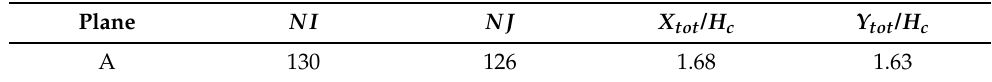
Table 1. Basic geometric and grid parameters: NI and NJ are the numbers of the grid lines with respect to the x and y direction, while X tot and Y tot are the x and y dimensions of the computational